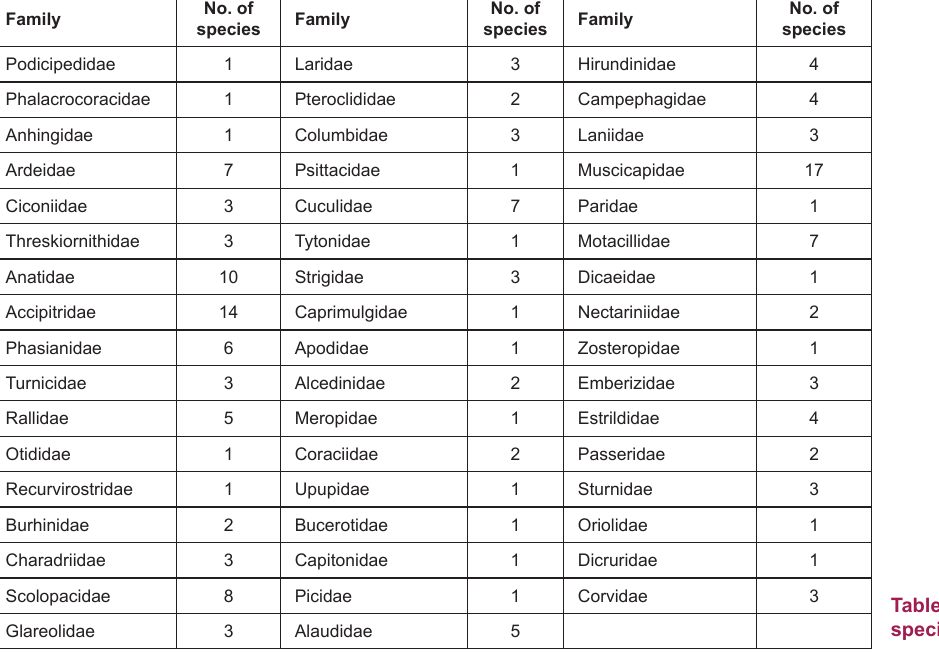
Table 1. Family wise bird species